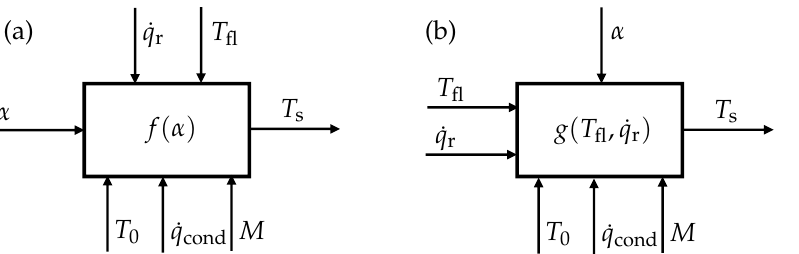
Figure 2. Model function of the surface temperature with input and output quantities and cross- sensitivities, ( a ): Flow-dependent heat transfer coefficient α as input quantity, ( b ): Analysis of the response behaviour for changing heat inputs, the flow properties in α are considered as a parameter of the system’s input–output relation